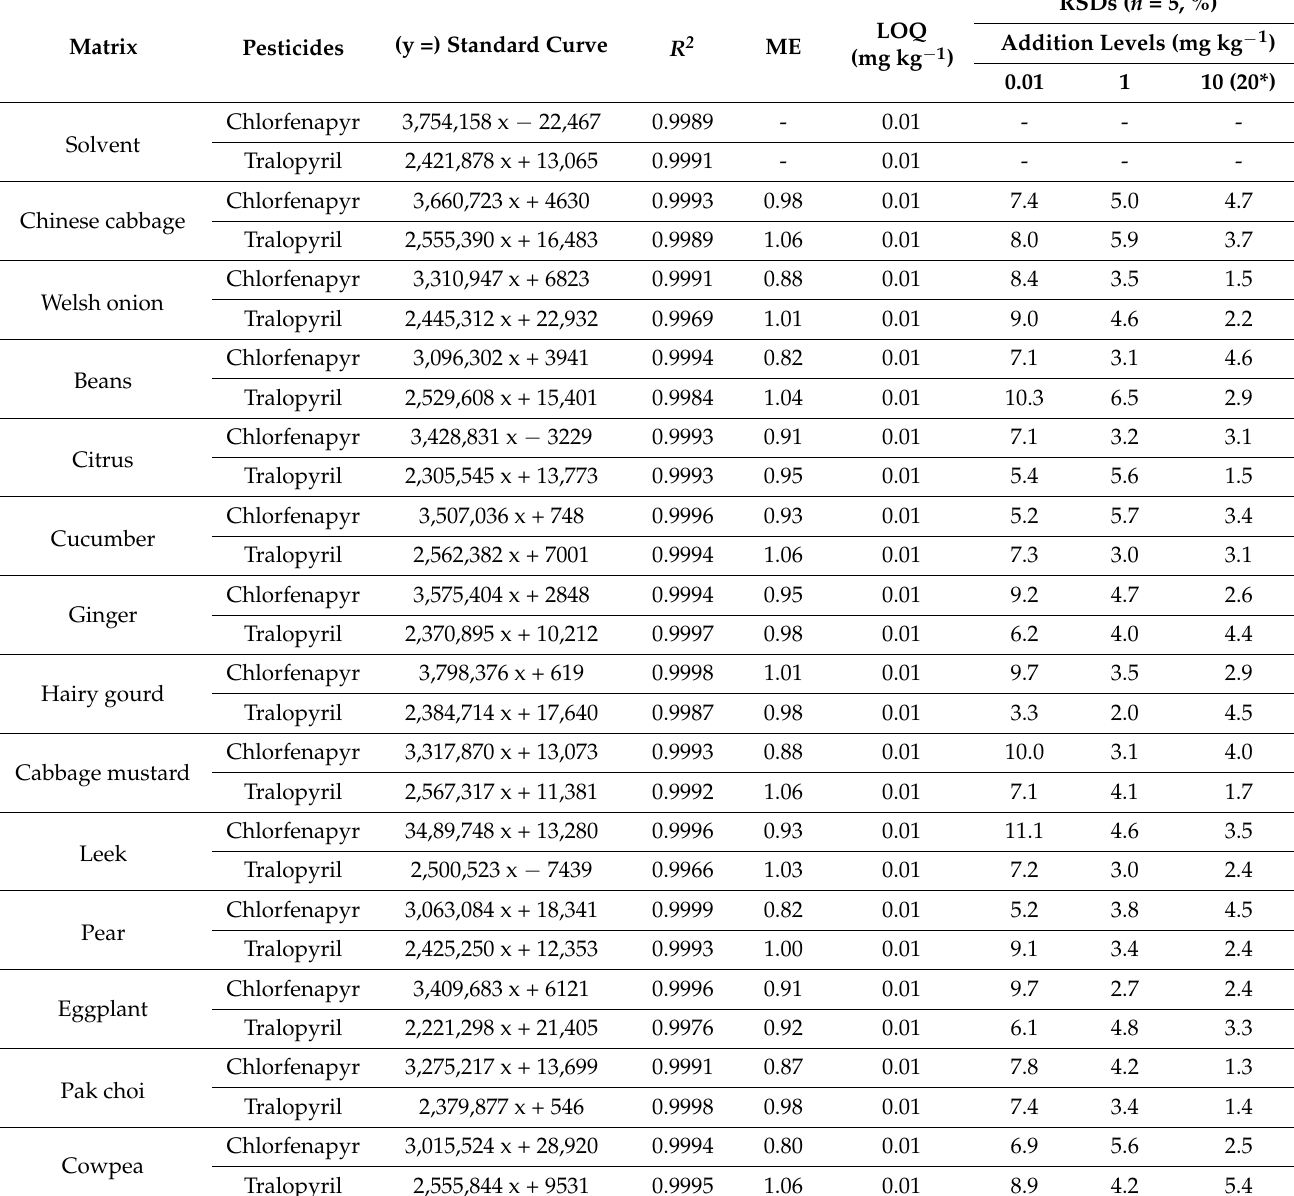
Table 1. Validation of linearity, ME, and LOQ of chlorfenapyr and